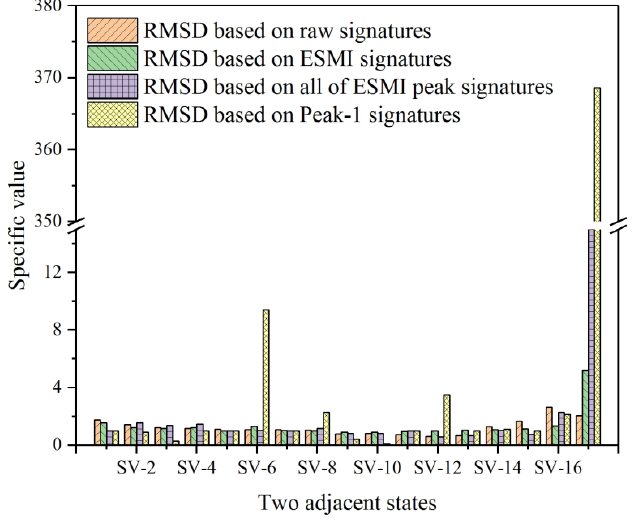
Figure 11. Histogram of specific values of two adjacent RMSD bars based on imaginary part